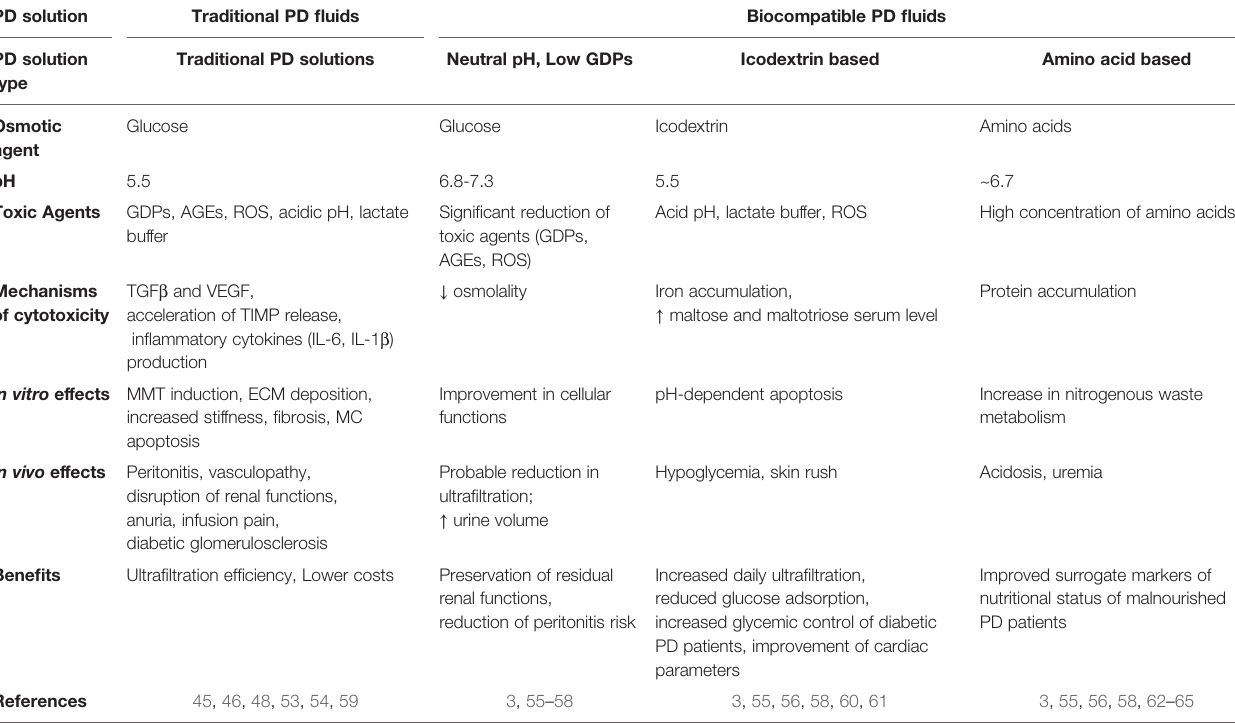
TABLE 1 | Table comparing the main characteristics of traditional versus biocompatible PD with emphasis on in vitro/in vivo mechanisms of toxicity. PD